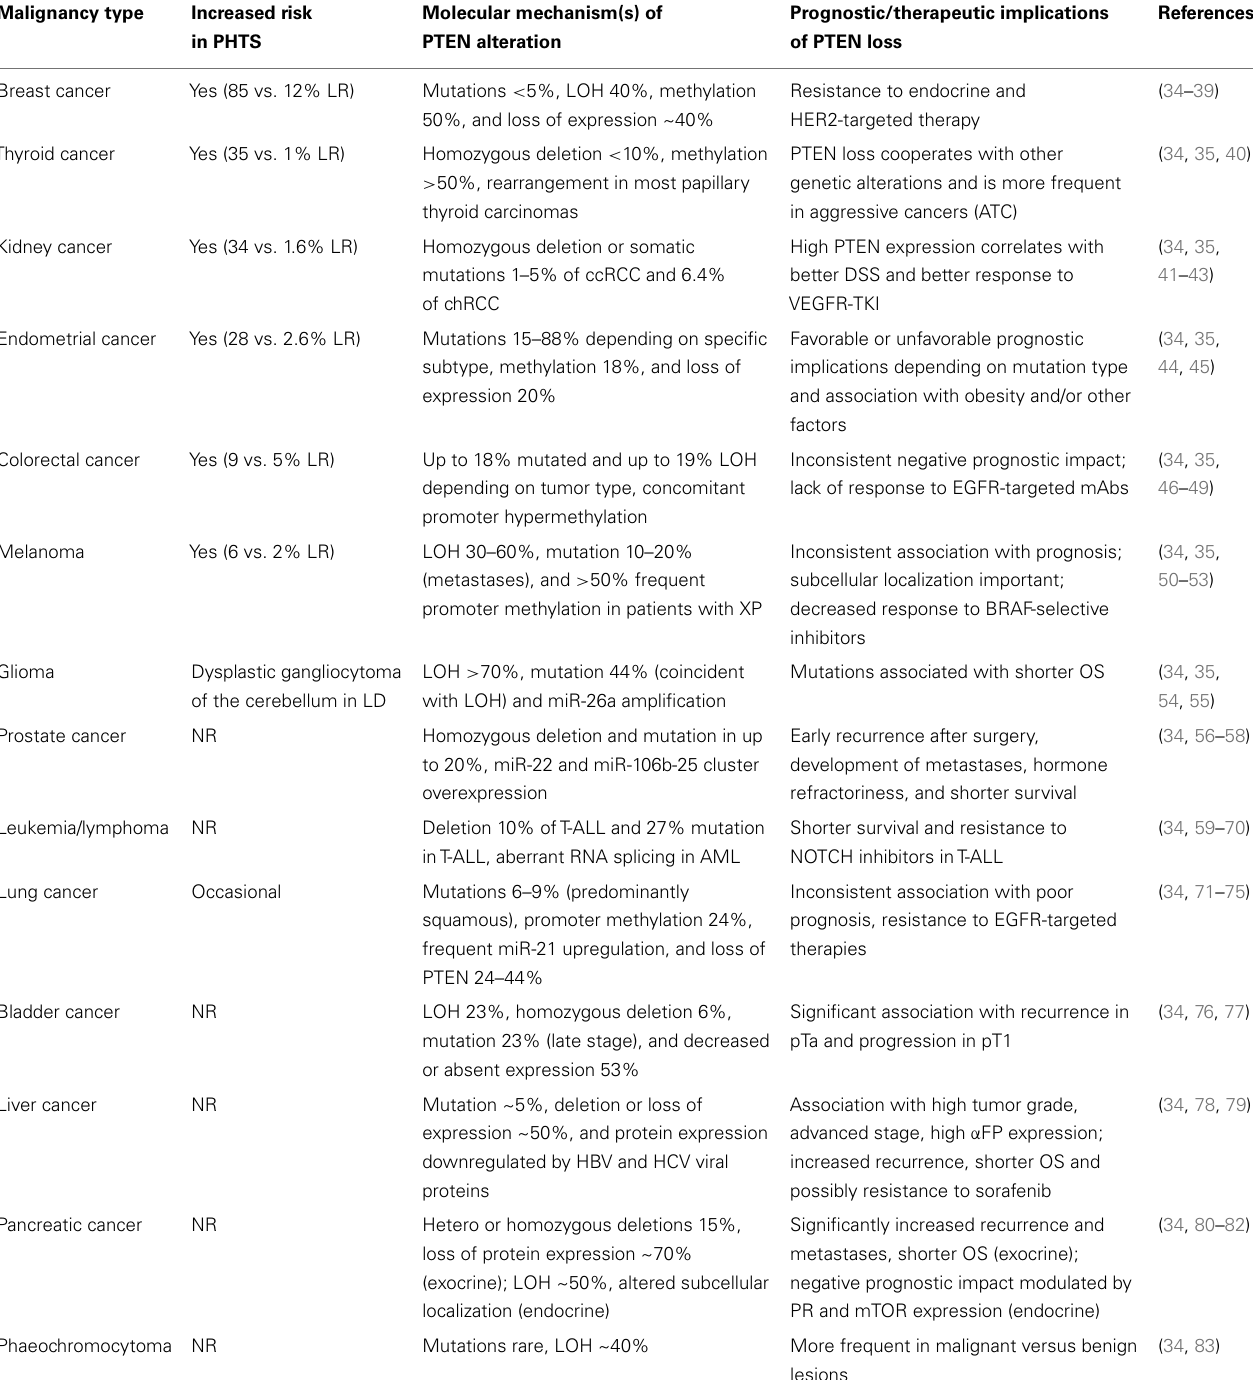
Table 2 | Incidence and prognostic significance of PTEN alterations in PHTS and sporadic human cancers